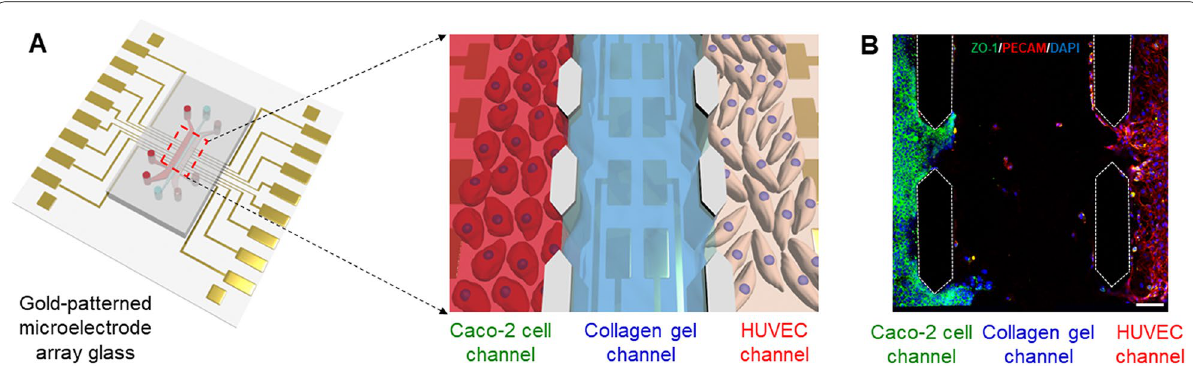
Fig. 1 The human gut‑on‑a‑chip with microelectrode arrays. A Schematic of the gut‑on‑a‑chip. The left channel was used to establish an intestinal lumen using human epithelial Caco‑2 cells. The right channel was employed to make a vascular lumen using HUVECs. The continuous flow of the culture medium was introduced by an osmotic pump. B Representative immunofluorescence results showing that ZO‑1‑positive Caco‑2 cells and PECAM‑1‑positive HUVECs were located in the left and right channel of a gut‑on‑a‑chip separated by collagen type I gels. Scale bar is 100 μm